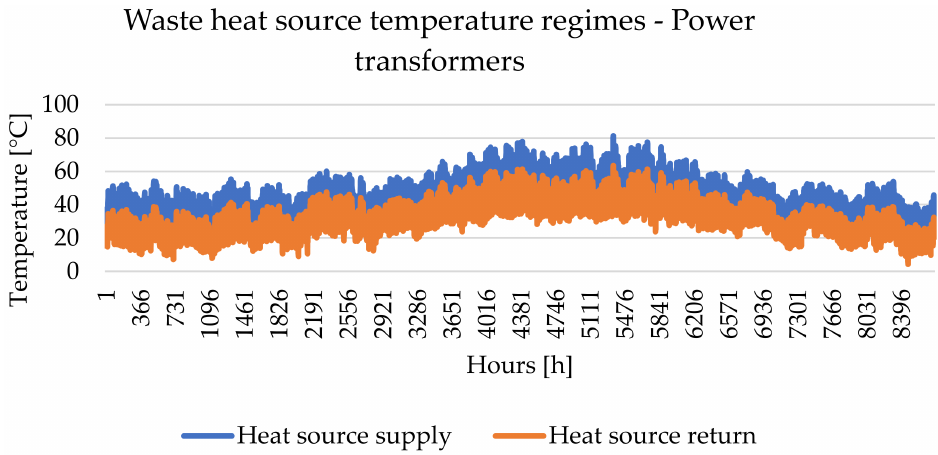
Figure A5. Waste heat temperature regimes—power